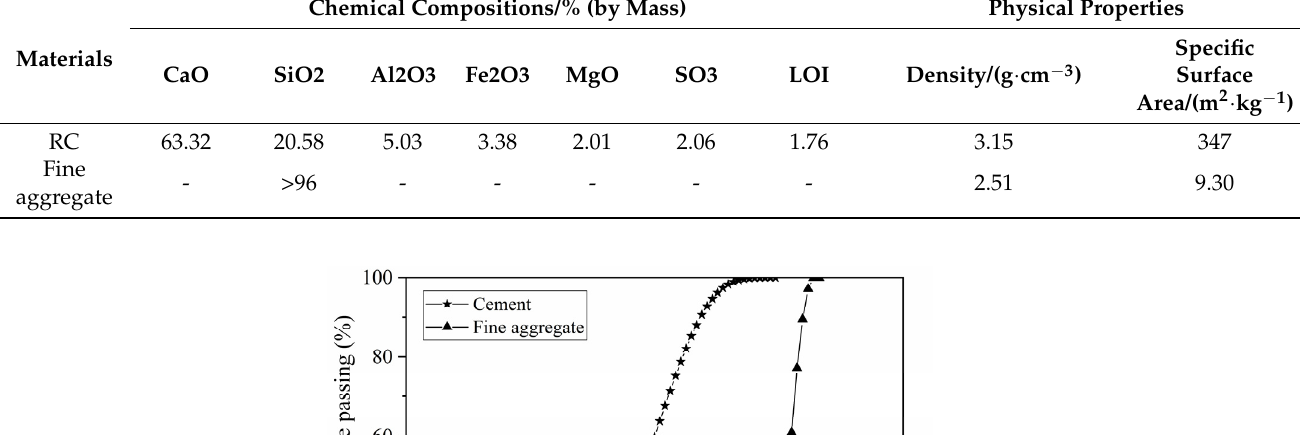
Table 1. Chemical compositions and physical properties of RC and fine aggregate.